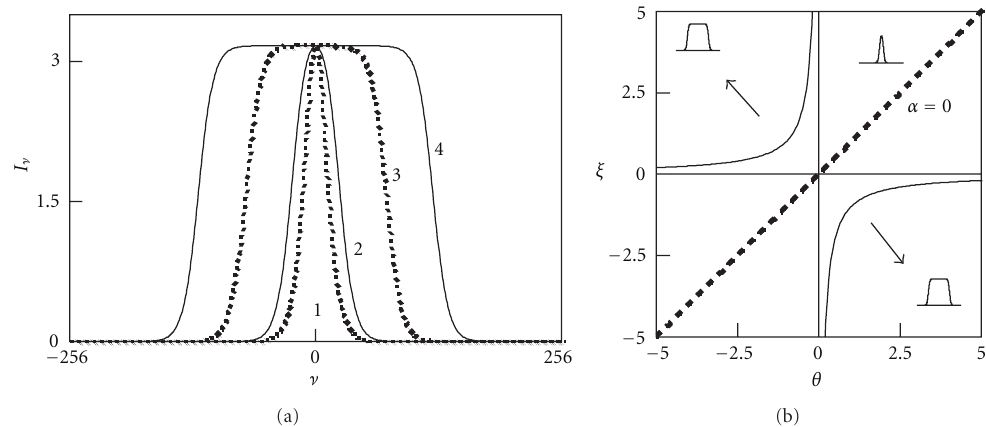
Figure 15: Spectra of ultrashort pulse described by (8). (a) Spectral profiles of established solitons with di ff erent chirps: (1) α = 0, (2) α = 1, (3) α = 3, (4) α = 5. (b) Variation of the chirp α on the plane of the nonlinear-dispersion parameters ( ξ , θ ). For the dashed line α = 0, for the ±√ 2, the arrows point the directions of maximal increase in the chirp α . The spectral profiles in the figure (b) demonstrate solid curves α = typical spectra for the three areas separated from each other by the solid curves.